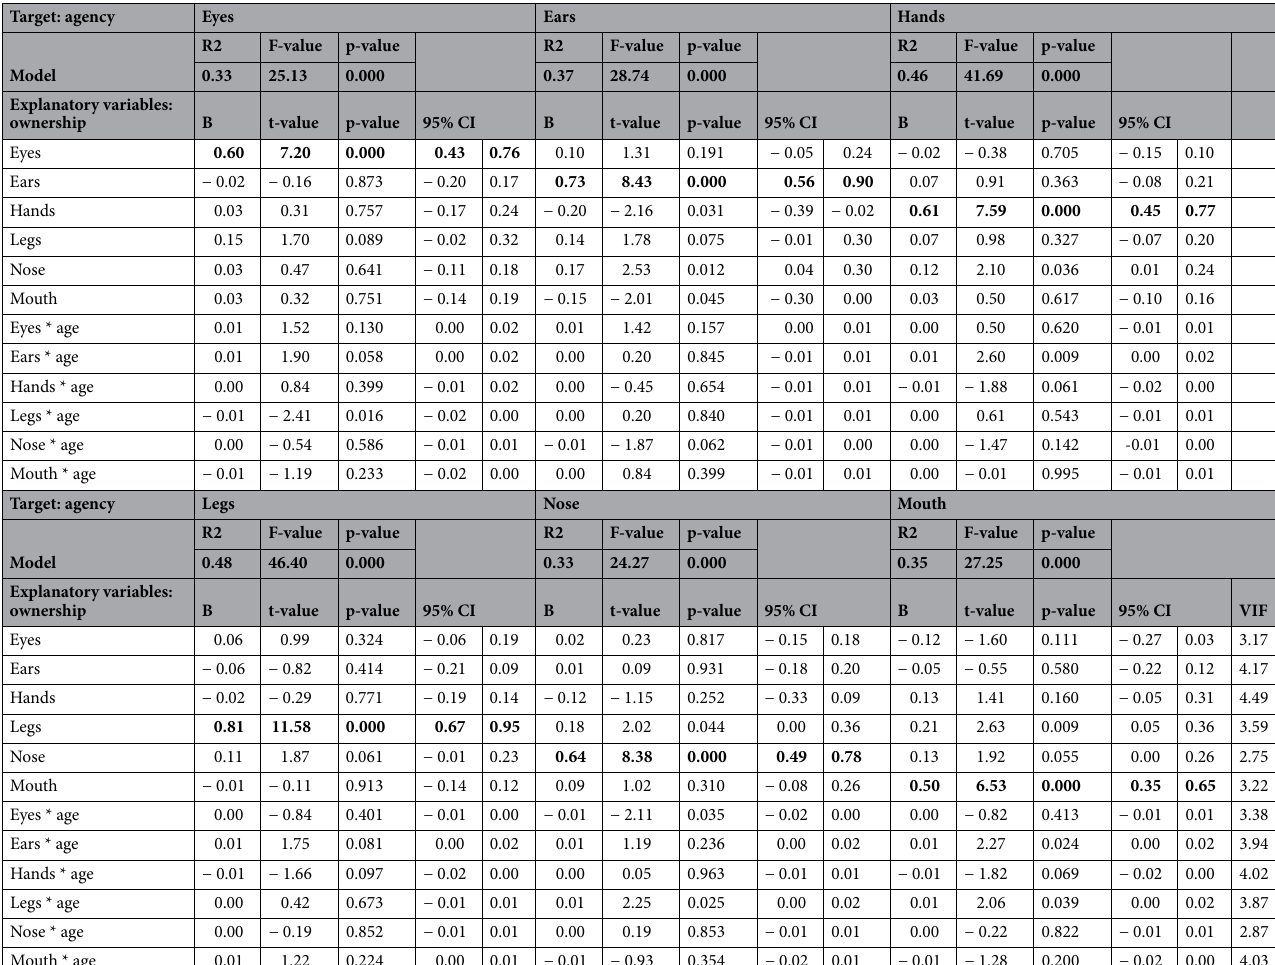
Table 1. Statistics of multiple regression analyses from the ownership sensations to agency sensation in each body part. Bold letters indicate significant beta